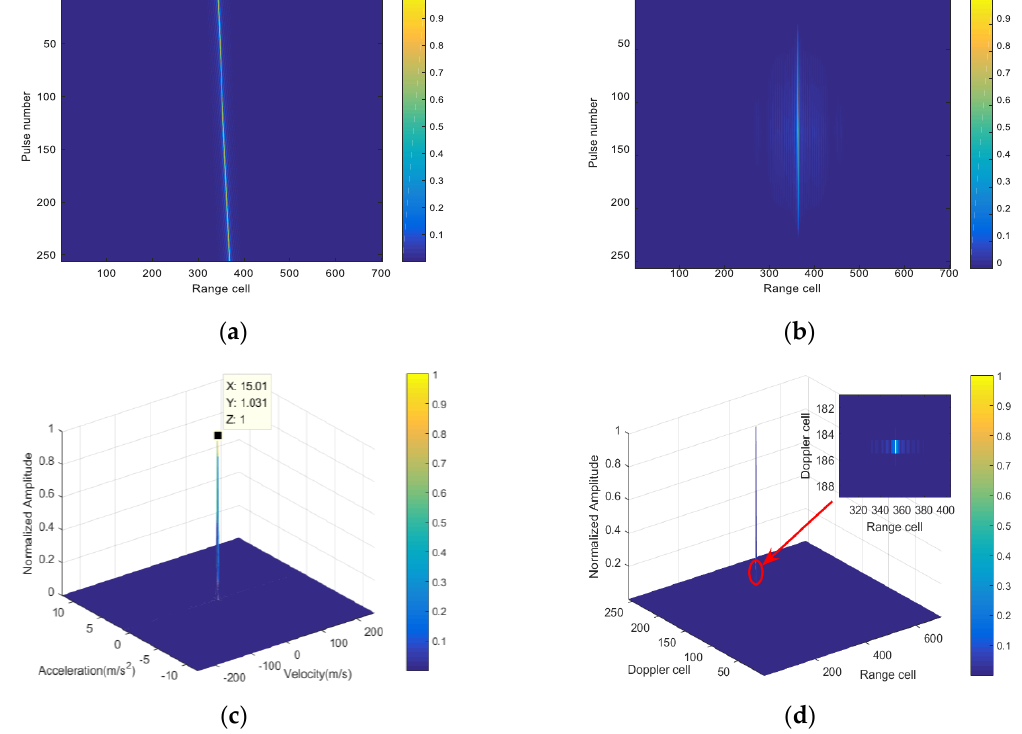
Figure 1. Simulation results of Example 1. ( a ) The result of pulse compression; ( b ) the result of the frequency-domain second-order phase difference (FD-SoPD); ( c ) velocity–acceleration distribution; ( d ) the result of coherent integration.